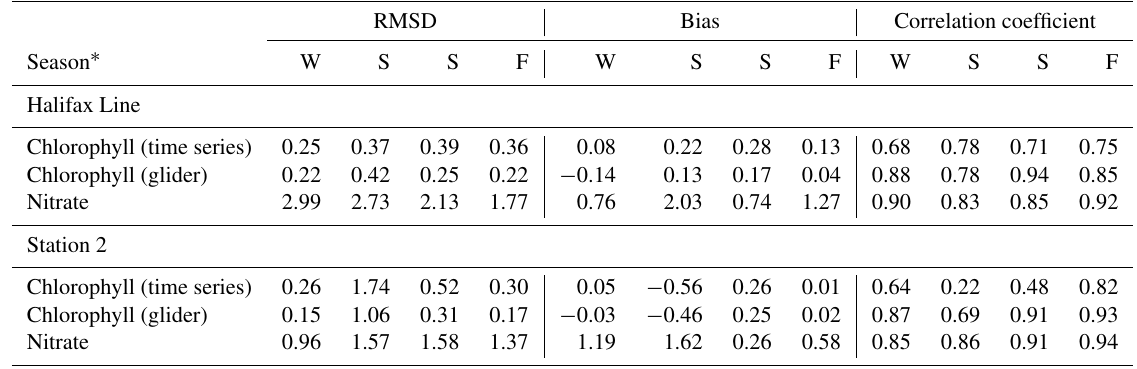
Table 3. Comparison statistics between ACM and AZMP and glider observations along the Halifax Line and at Station 2. RMSD Bias Correlation coefficient Season ∗